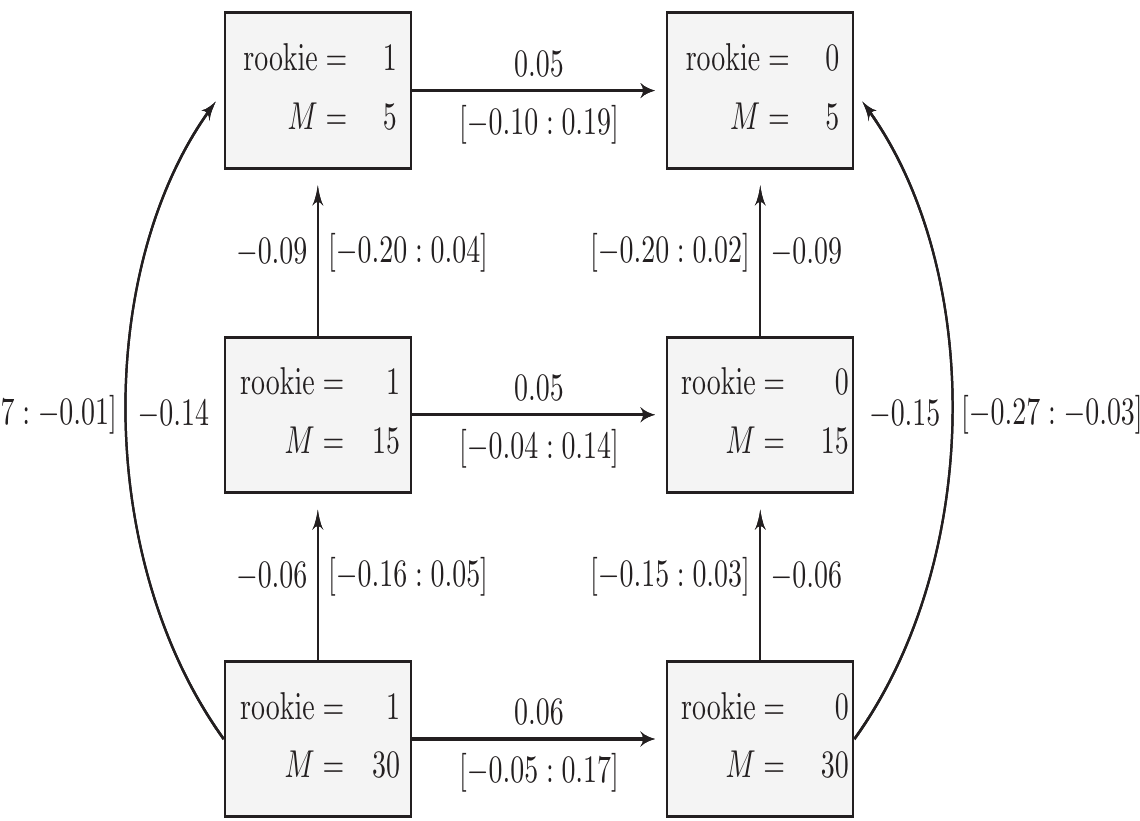
Figure 4. Second-order interaction first differences for closed lists ( open = 0